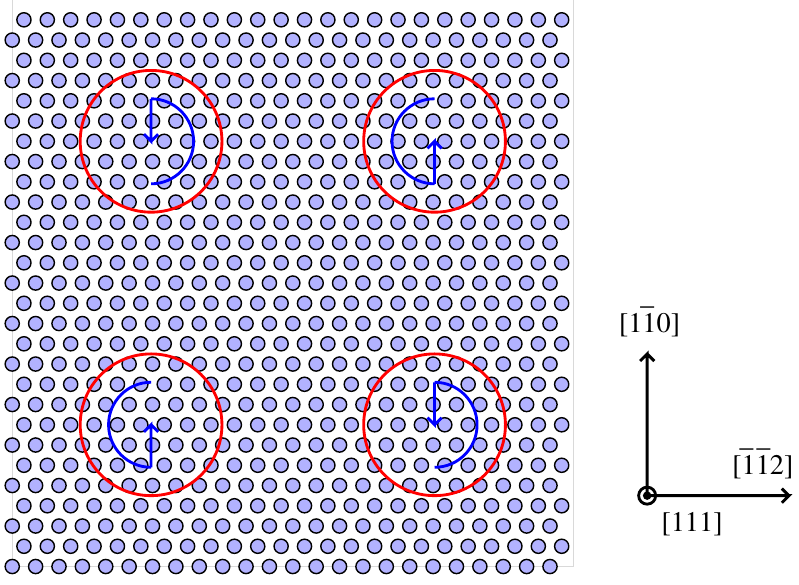
Figure 3. Schematic images of the quadrupole dislocation construction used in the simulation. The blue arrows indicate the helicity of the dislocations, with “up” and “down” arrows corresponding to screw dislocations of Burgers vectors b = a /2 (cid:104) 111 (cid:105) and − b , respectively. The red circles indicate the effective binding